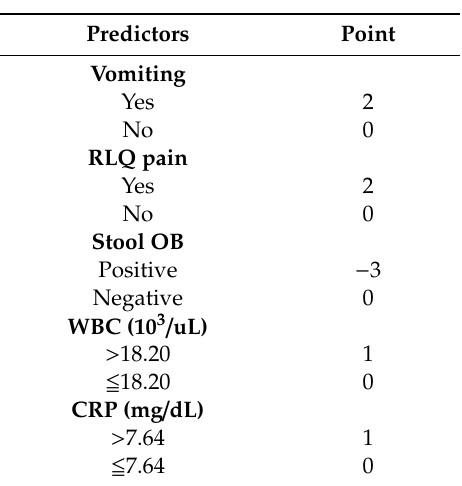
Table 6. Revised model